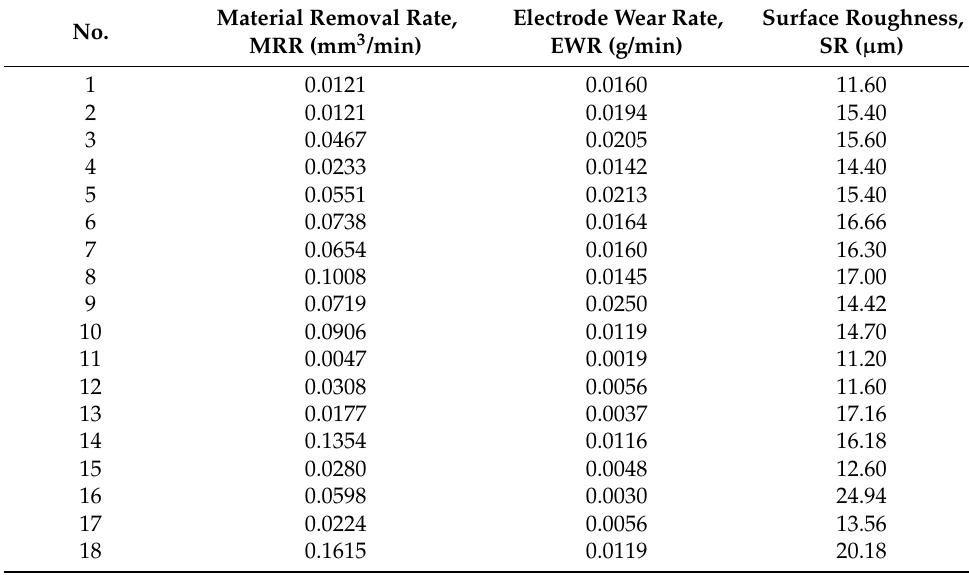
Table 7. Experimental result for machining performance.